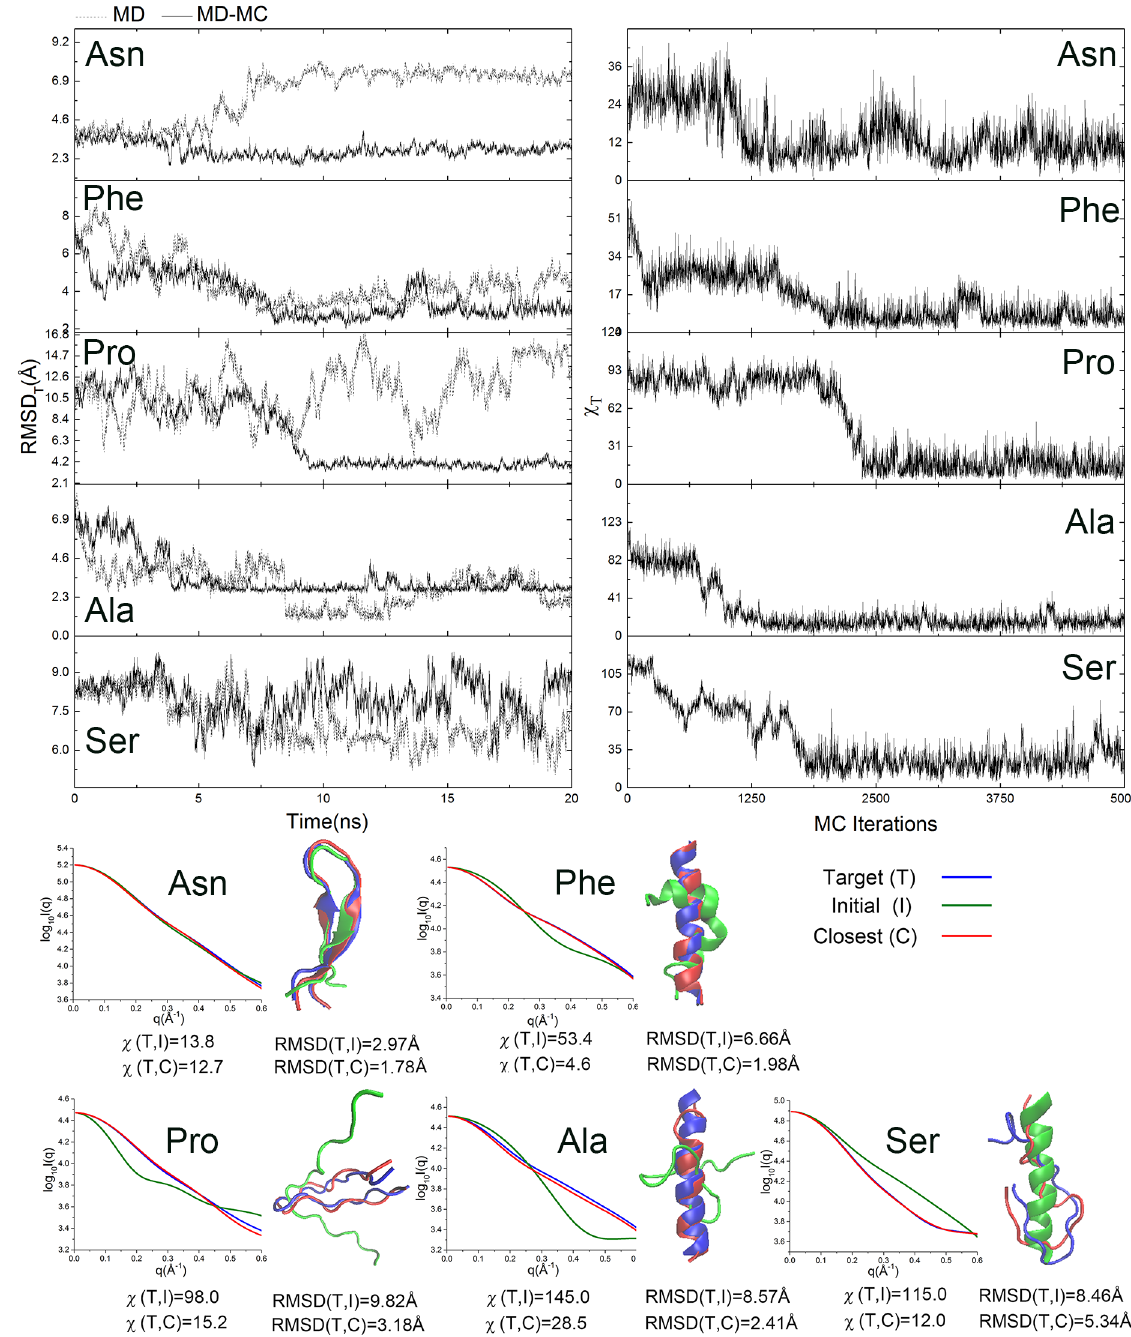
Fig 8. Sampling performance of the MD-MC method in five representative trajectories. The time evolution of RMSD T for MD-MC (solid line) and MD (dash line), the time evolution of χ T , as well as 3D structures and SAXS profiles of the initial (I), the target (T) and closest (C) structures for trajectories of Poly-Asn, Poly-Phe, Poly-Pro, Poly-Ala and Poly-Ser are